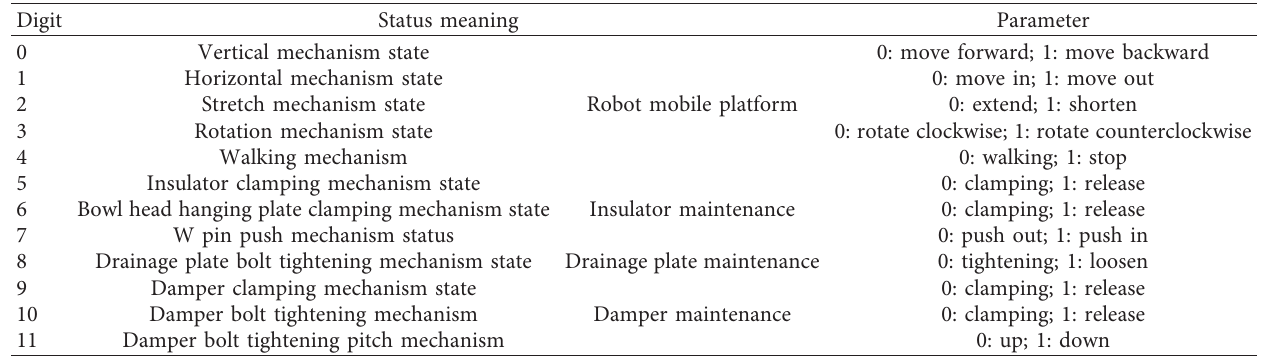
Table 4: Robot state vector.